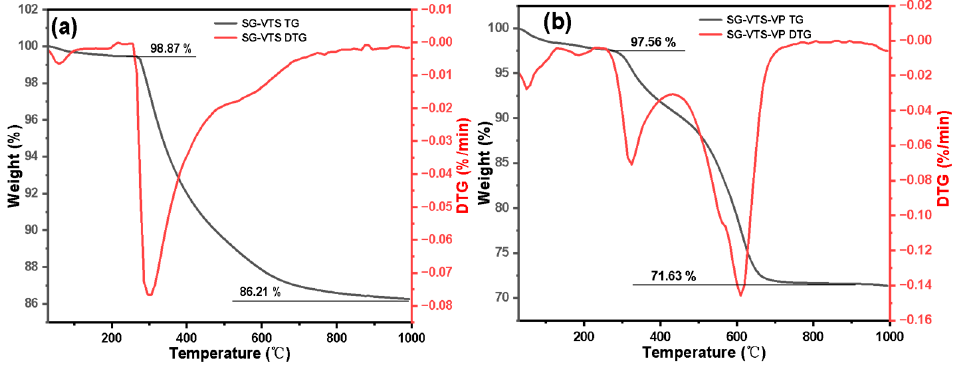
Figure 9. Thermogravimetric curve of SG-VTS ( a ) and SG-VTS-VP ( b ). Pore size distribution of SG, SG-VTS, SG-VTS-VP, and SG-VTS-VPQ are shown in Figure 10. For SG, the specific surface area and maximum probability pore size calculated by the BET method and the BJH method are 540.9 m 2 · g − 1 and 7.92 nm, respectively. As the grafting reaction progresses, the maximum probability pore size and specific surface area